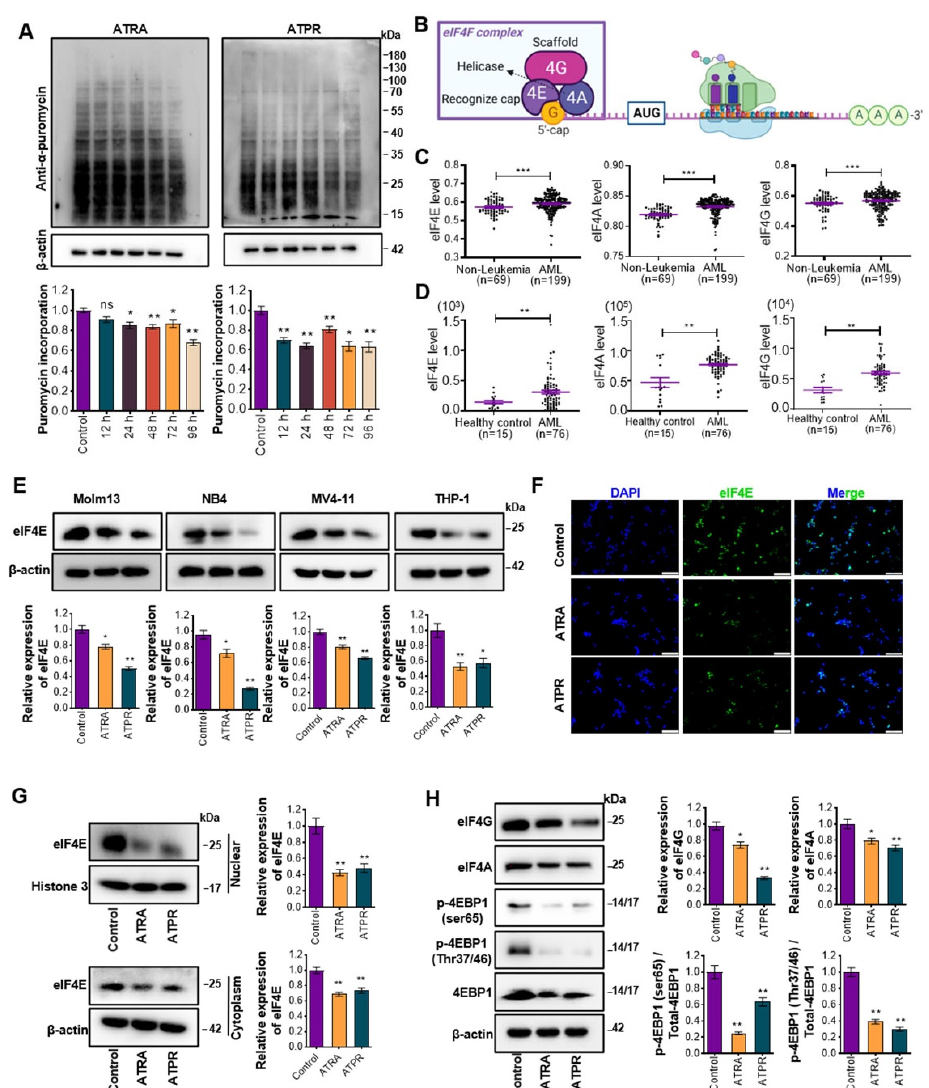
Figure 1. ATRA and ATPR inhibited global translation and protein synthesis. ( A ) Global nascent peptide synthesis was measured by puromycin incorporation assay and detected using western blot with anti ‐α‐ puromycin antibodies. ( B ) Schematic representation of the eIF4F complex during translation. ( C and D ) The expression level of eIF4F complex components eIF4E, eIF4A, and eIF4G in AML patients compared with healthy controls or patients without leukemia were analyzed via retrieving the microarray data in the Gene Expression Omnibus (GEO) datasets (C, GSE15061; D, GSE12662). ( E ) Protein expression of eIF4E in AML cell lines Molm13, NB4, MV4 ‐ 11, and THP ‐ 1 with ATRA or ATPR exposure were analyzed by western blot. ( F ) Immunofluorescent staining of Molm13 cells showing expression of eIF4E (Green) with DAPI (Blue); bar, 100 μ m. ( G ) Western blot analysis showing the distribution of eIF4E in cytoplasmic and nuclear of Molm13 cells with ATRA or ATPR exposure (10 μ M, 72 h). ( H ) Western blot analysis showing protein level of eIF4G, eIF4A, eIF4EBP1 (4EBP1), and phosphorylation level of 4EBP1 at ser65 and Thr37/46 in Molm13 cells during ATRA or ATPR stress. β‐ actin served as a loading control. ns: no significance, * p < 0.05; ** p < 0.01; *** p < 0.001.